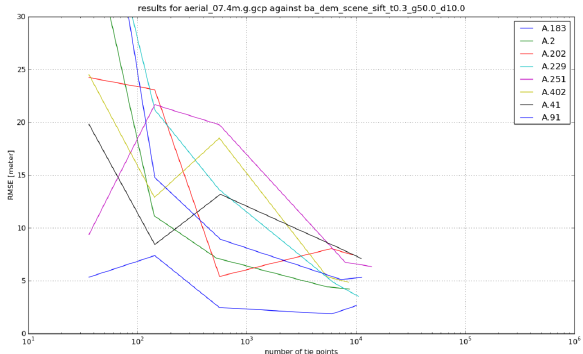
Figure 4: Evaluation of lateral accuracy vs number of SIFT tie points. Each line corresponds to a scene overlapping with Test area 7.